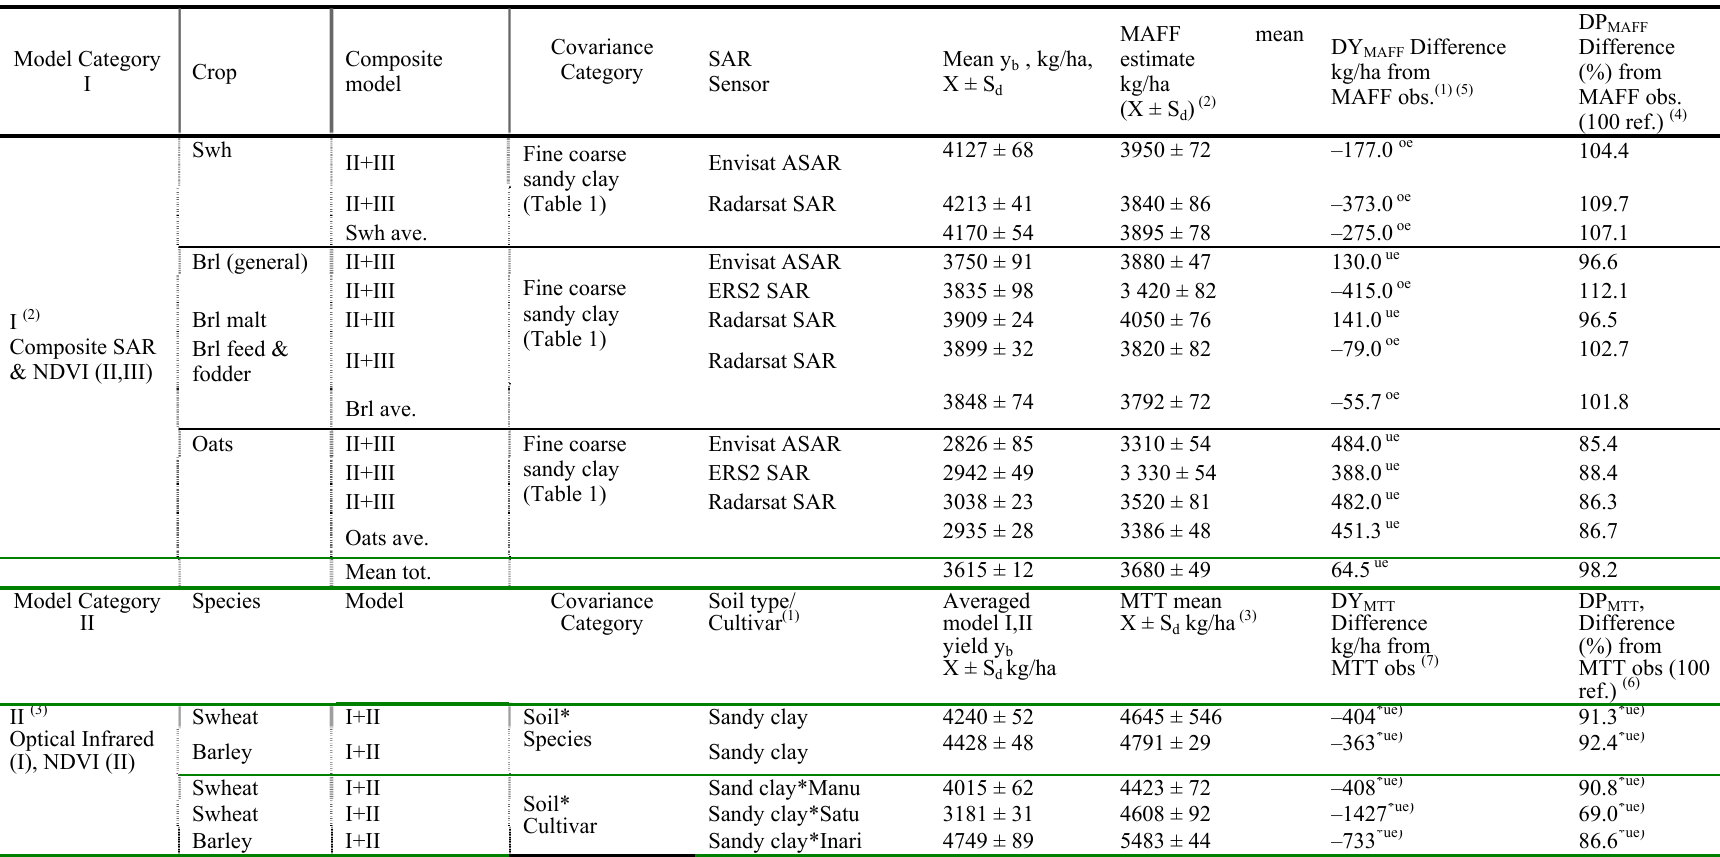
Table 6. Cereal composite SAR and optical VGI model baseline yield (y observed values in the Etelä-Pohjanmaa Agric. Advisory Centre [30,56,71] (1)